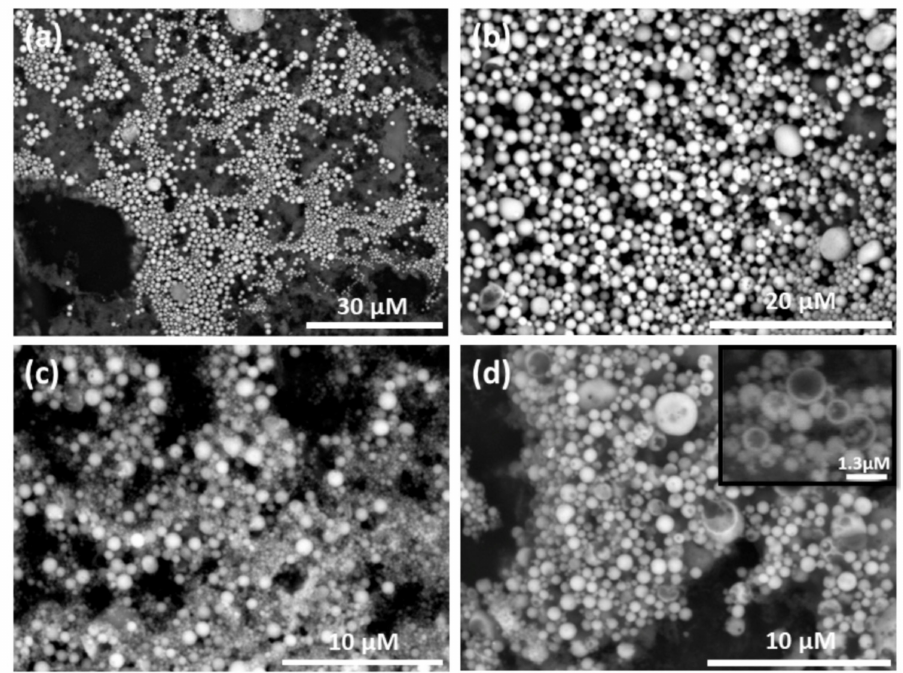
Figure 1. Scanning electron micrographs of self-assembled titania nanoshells. ( a ) Lower magnification micrograph of nanoshells dispersed over a matrice. ( b ) Micrograph of titania nanoshells of rather narrow size distribution. Average diameter calculated from 40 random nanoshells was ca. 1 µ m (standard deviation (SD) 760 nm). ( c ) An example of nanoshells with higher size distribution. ( d ) Micrograph with several broken nanoshells. Average diameter calculated from 40 random nanoshells was ca.